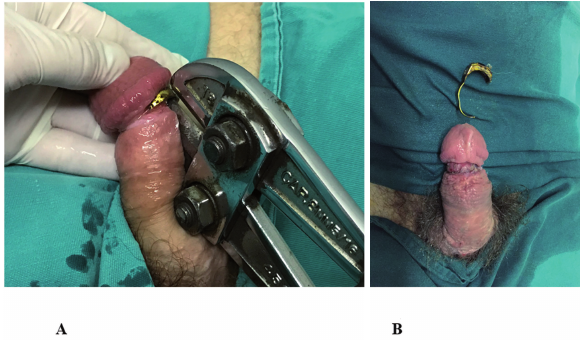
Figure 4 - Patient with penile incarceration produced by metallic ring. Metallic ring removal through orthopedic cutting plier (A). Final appearance of the penile shaft after penile constrictor removal